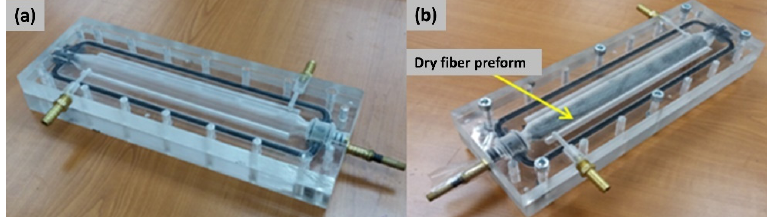
Figure 4. Acrylic mold prototype design for manufacturing a tubular section ( a ) mould without preform ( b ) mould with dry fabric preform.